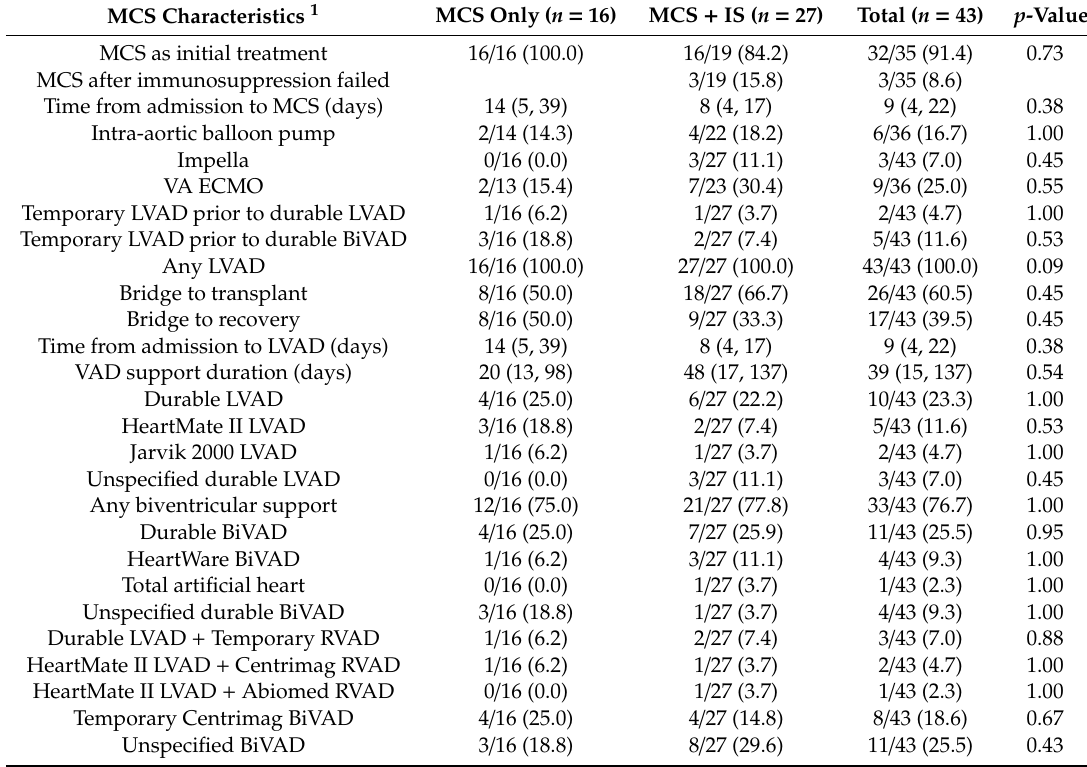
Table 2. MCS characteristics in patients with GCM.